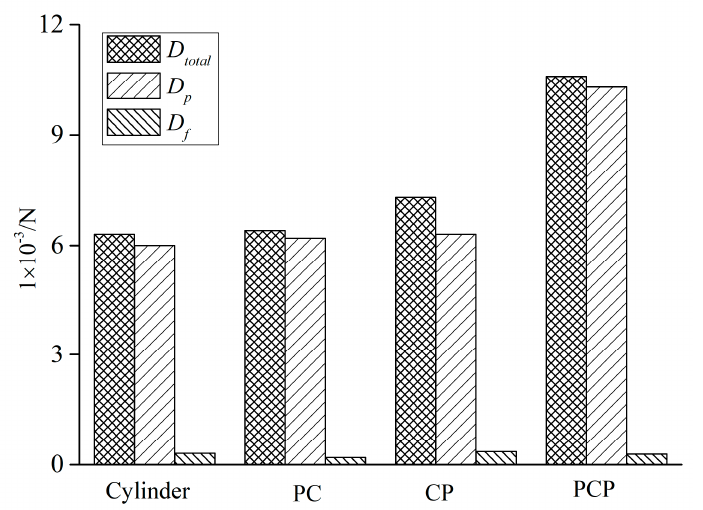
Figure 6. Comparison of time-averaged drag force acting on the cylinder surface. Table 3. Comparison of time-averaged flow drag for the four schemes.